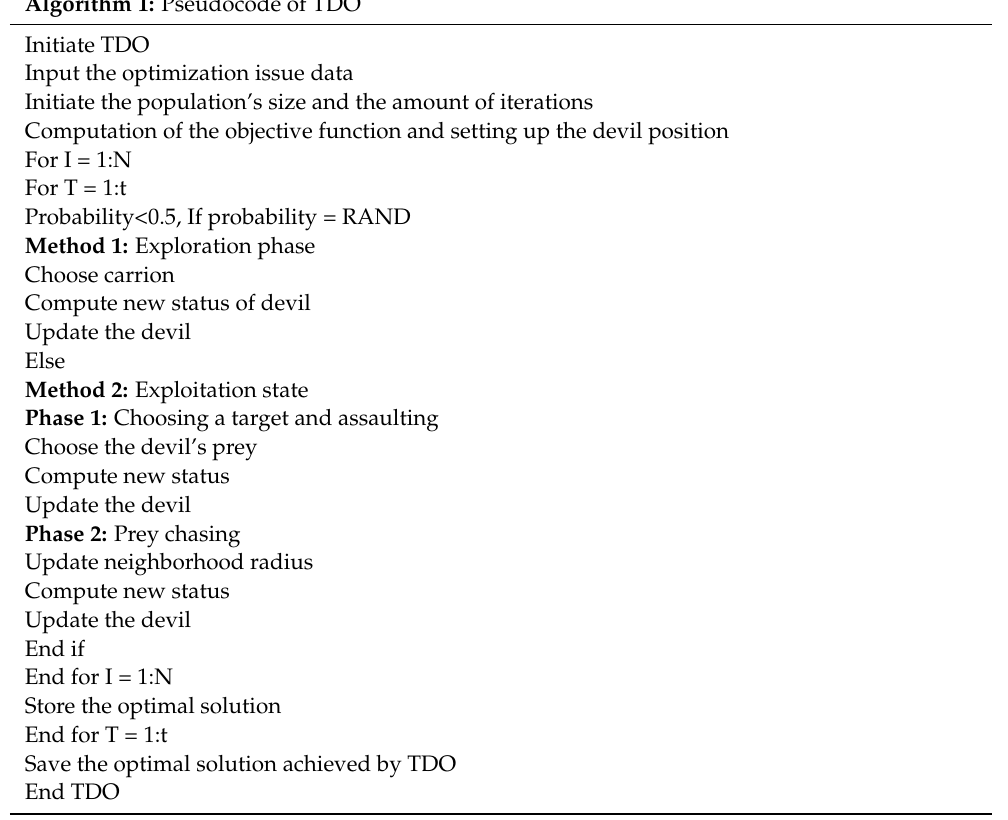
Algorithm 1: Pseudocode of